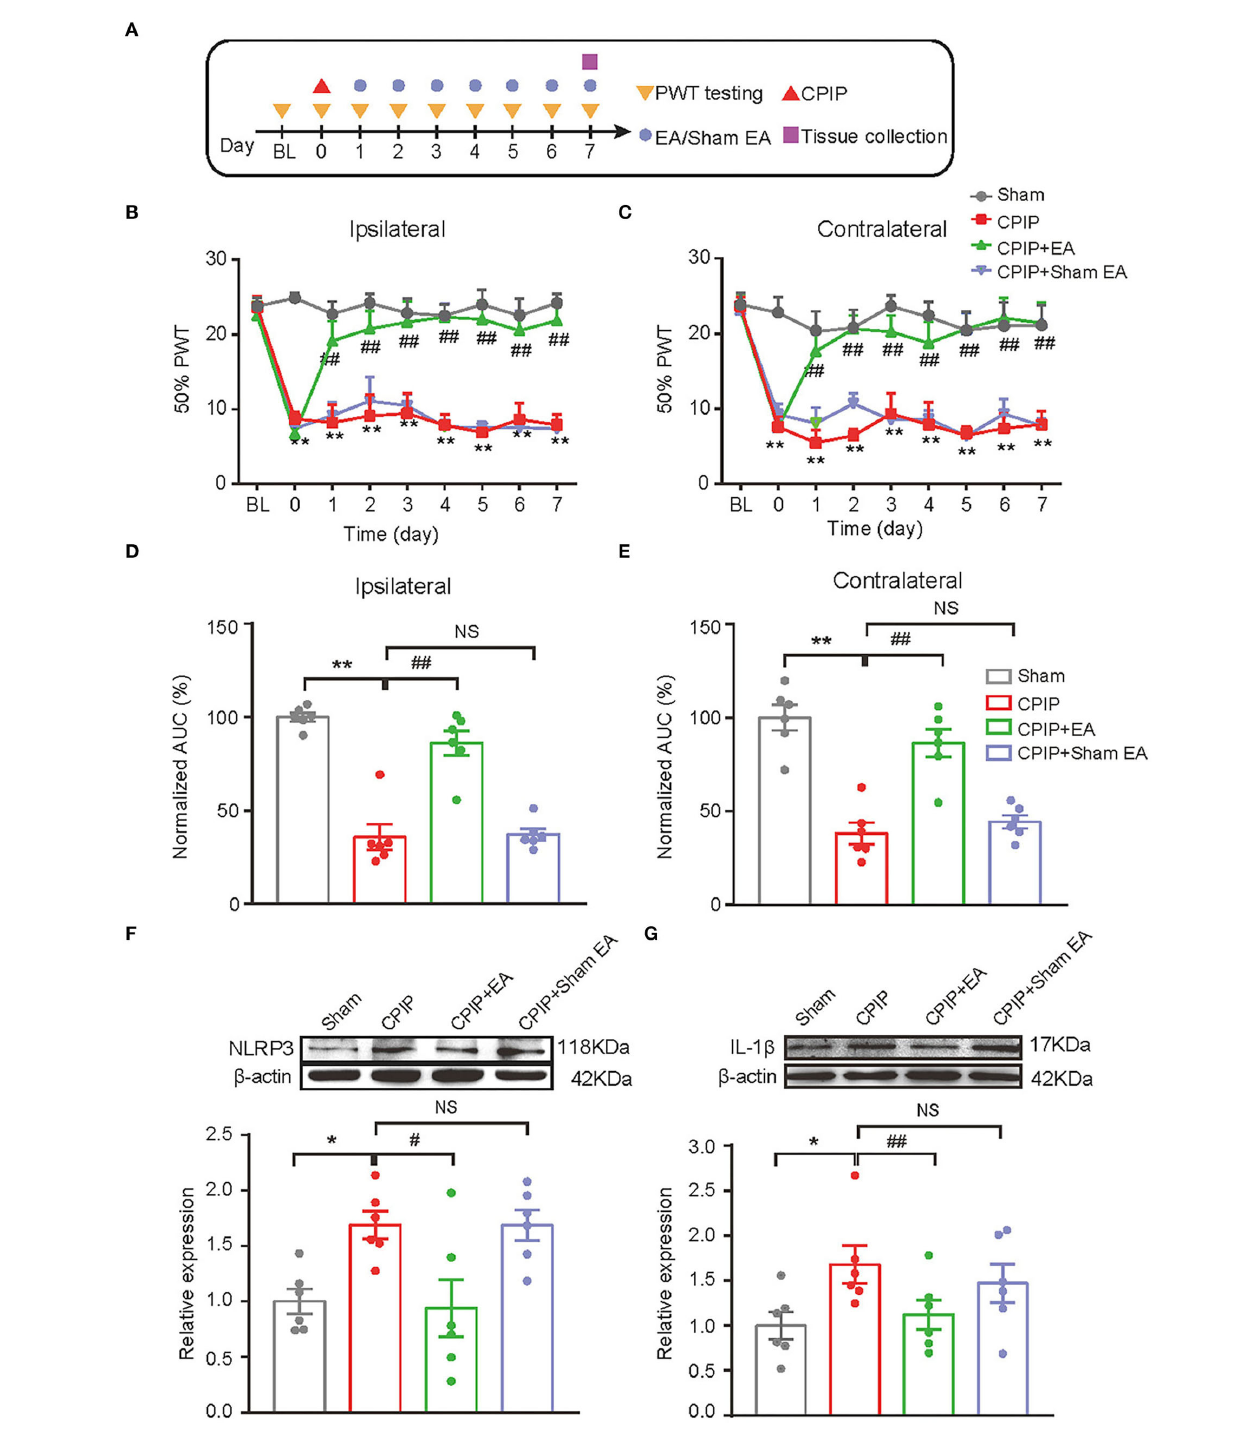
FIGURE 2 | EA intervention attenuated mechanical allodynia of CPIP model rats and reduced NLRP3 inflammasome activation in spinal cord. (A) Experimental protocol showing time points for model establishment and EA intervention. (B,C) 50% PWT changes in ipsilateral (B) or contralateral (C) hind paw following EA/sham EA intervention. (D,E) Normalized AUC calculation from panel B&C. (F,G) Western blot showing protein expression of NLRP3 (F) , IL-1 β (G) in ipsilateral spinal cord tissues. The upper panel shows representative Western blot images and the lower panel shows the summarized data. β -actin was used as a reference control. n = 6 rats/group. * p < 0.05 vs. Sham group. ## p < 0.01, # p < 0.05 vs. CPIP group. NS, no significance vs. CPIP group. Two-way ANOVA with Tukey’s post-hoc test was applied in panels B&C. One-way ANOVA with Tukey’s post-hoc test was applied in (D–G) .